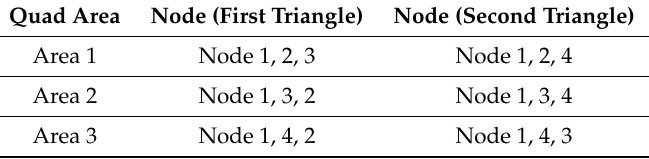
Figure 3. Another example of how picking the wrong nodes to divide a quad into two triangles (blue and yellow) can cause error due to area overlap (green), demonstrating how an assumption cannot be made by searching for the longest vector between two nodes. Table 1. Three different areas of two triangles; the maximum total area represents the correct area of the quad element